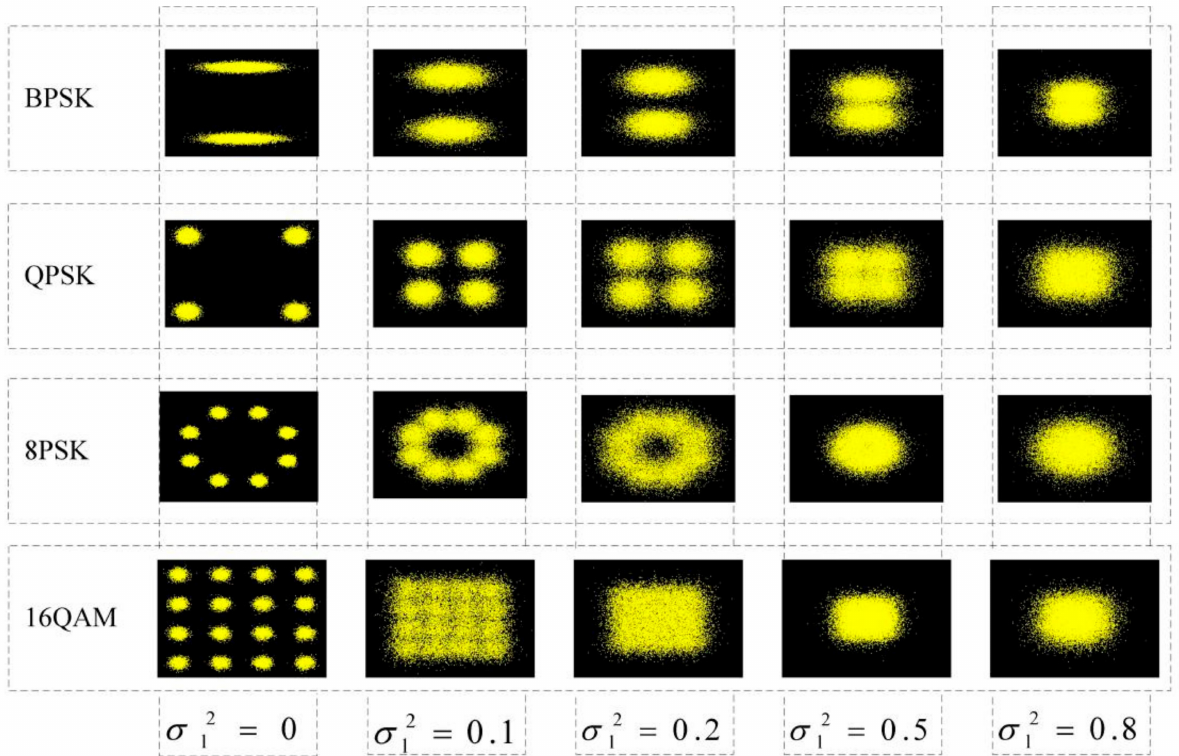
Figure 2. Comparison diagram of OFDM signal constellations of four modulation formats under different turbulence